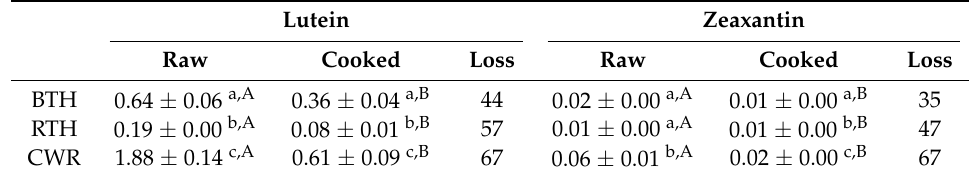
Mean values within a column superscripted by the same letter are not significantly different at p < 0.05. Mean values within a row in raw and cooked samples superscripted by the same capital letter are not significantly different